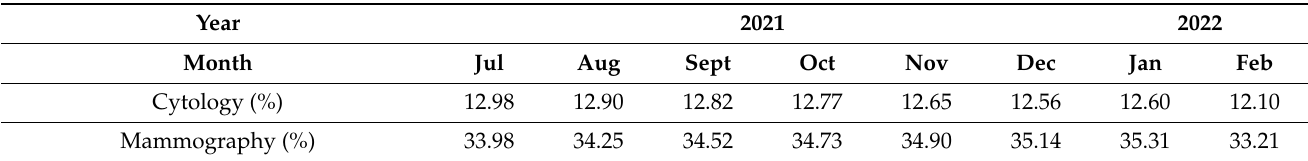
Table 2. Cancer screenings coverage in eligible population of women in Poland. Period: July–December 2021; January–February 2022. Percentages reported by the NHF on the first day of each month.